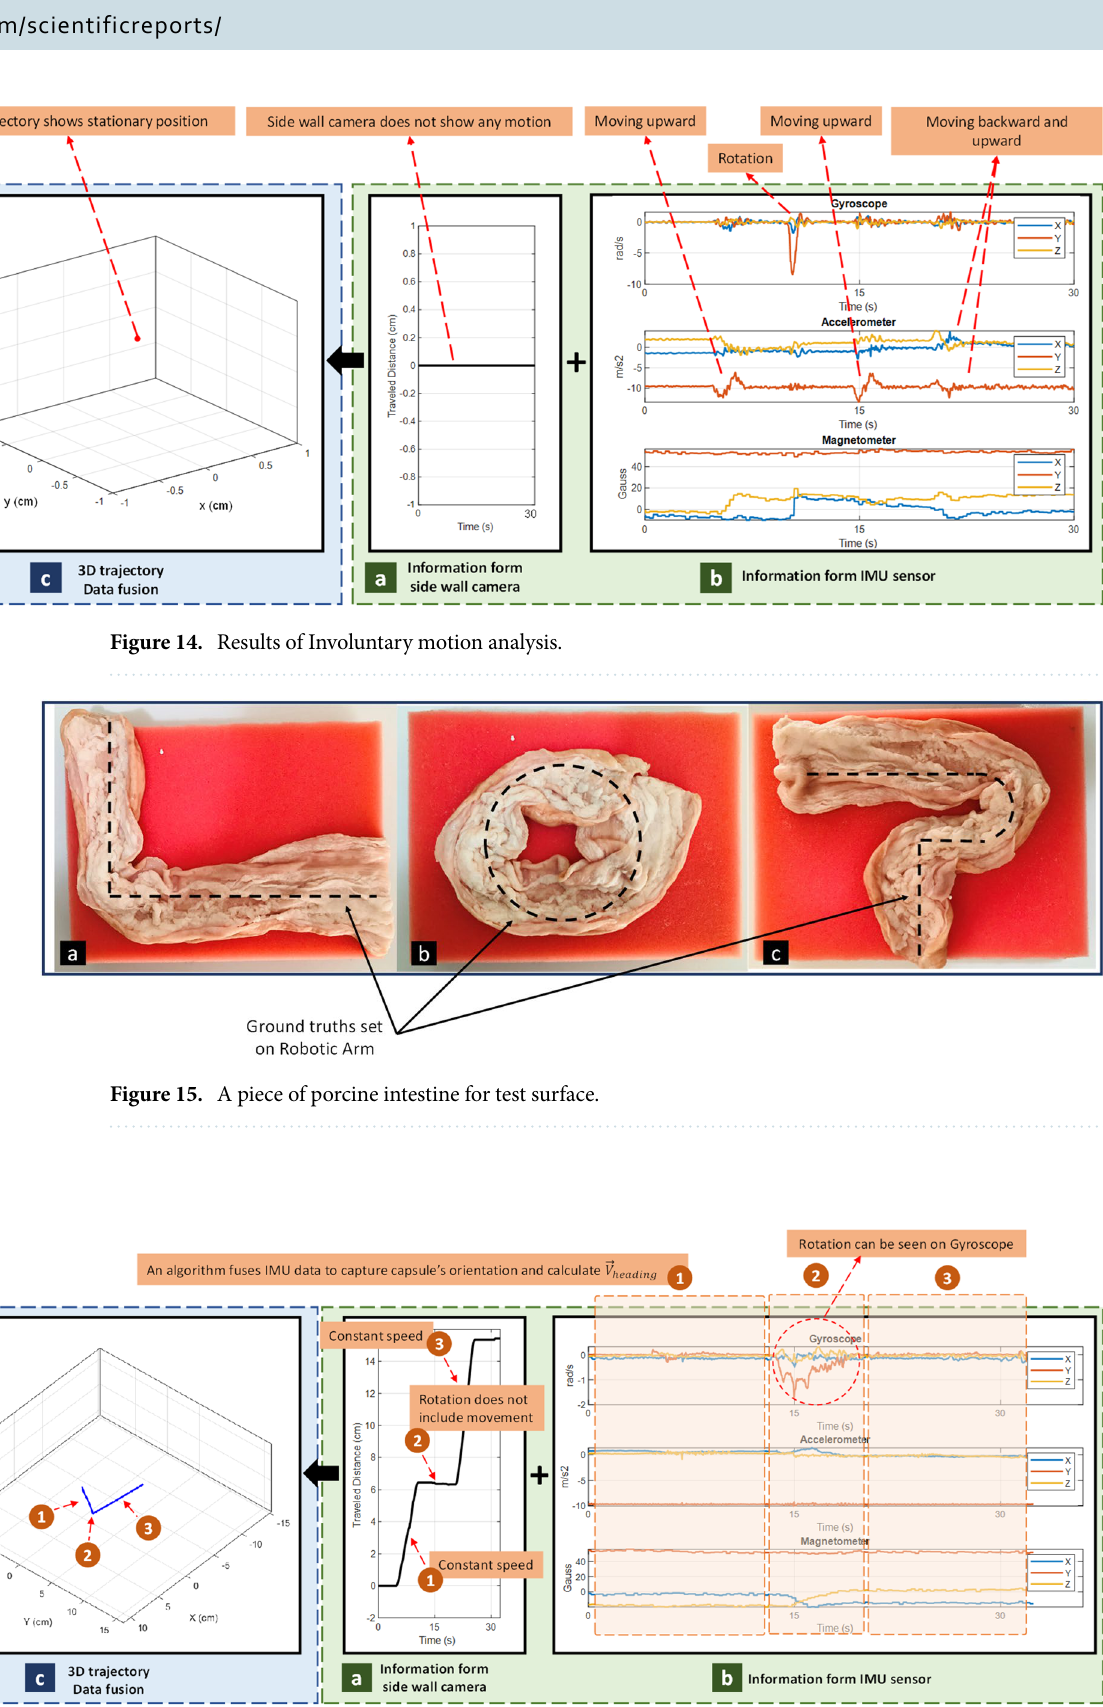
Figure 16. Results of 3D tracking